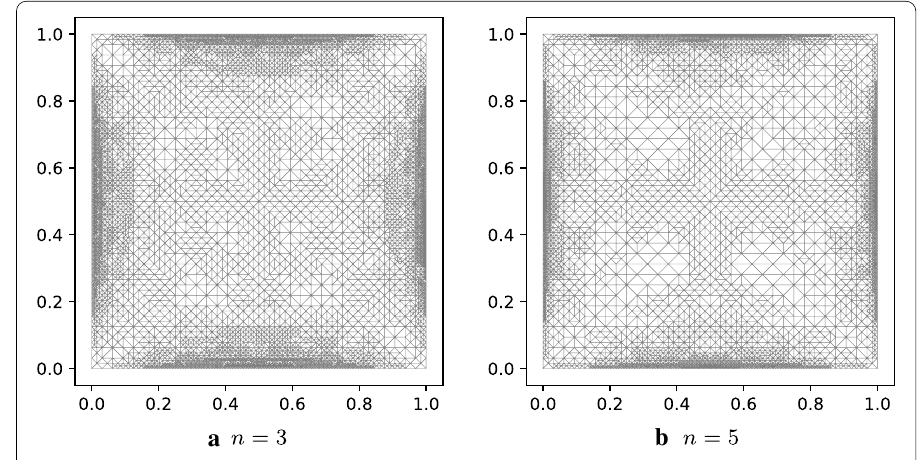
Fig. 4 Final refined meshes for the homogeneous plate for different thickness discretization levels